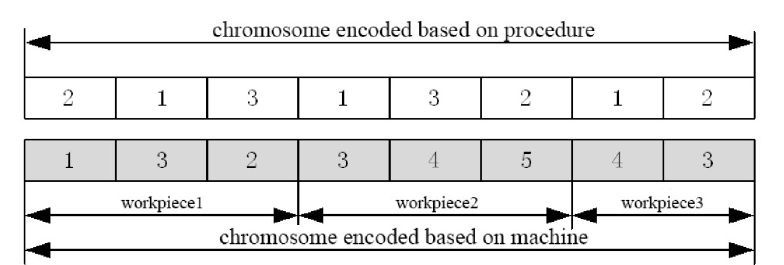
Figure 1. 2-level integer encoding based on procedure and